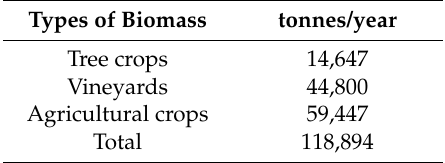
Table 2. Annual quantities of pruning products, Regional Unit of Crete [59].